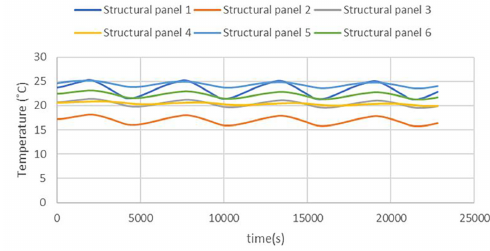
Fig. 6: Solar panels temperature change.